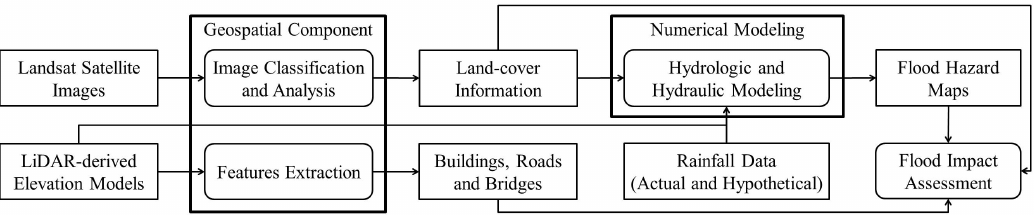
Figure 2: A combined geospatial and 2D numerical modeling approach for flood impact